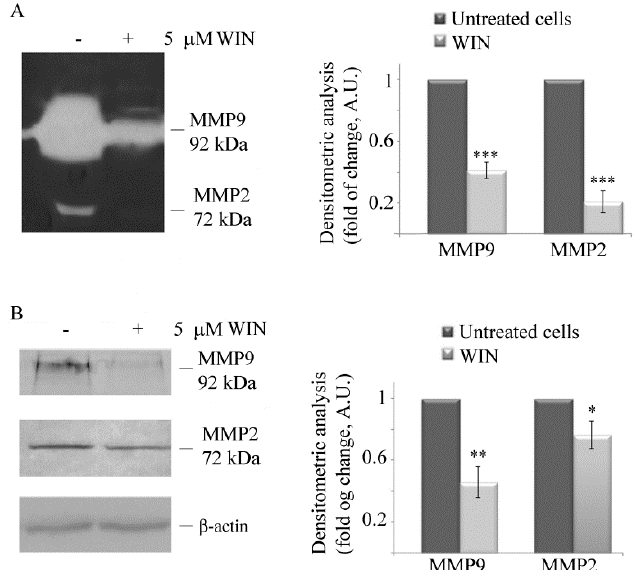
Figure 2. WIN treatment inhibits metalloprotease activities. Gelatin zymography ( A ) and Western blotting analysis ( B ) of the metalloproteinases MMP2 and MMP9 in MG63 cells treated for 36 h with 5 µ M WIN. Arrows indicate the relative bands at 72 kDa (MMP2) and 92 kDa (MMP9). Blots are representative of three independent experiments with similar results. Densitometric analysis is reported in the histograms. (*) p < 0.05, (**) p < 0.01 and (***) p < 0.001 compared to the untreated sample. In ( A ), volumes containing equal amount of proteins were loaded, in ( B ), densitometric measurements were made after normalization with β -actin.